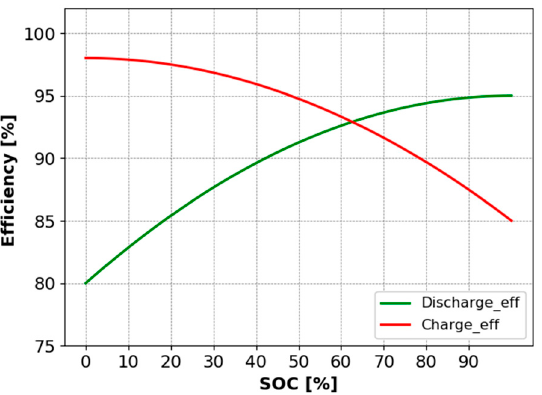
Figure 10. Charge/Discharge efficiency vs. SOC considered for the battery (data from [49]).